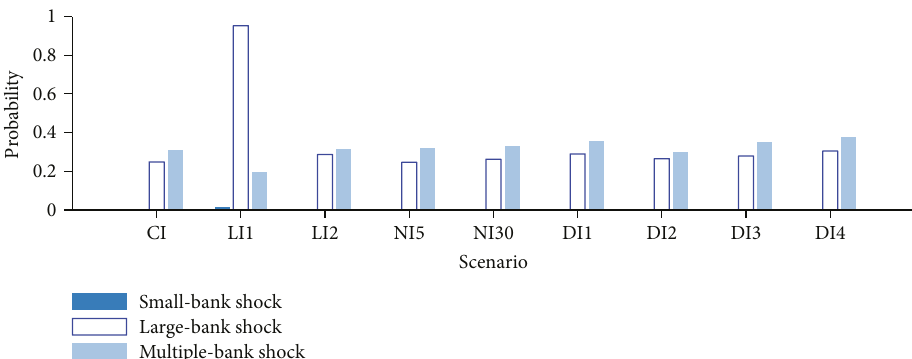
Figure 15: Probability of systemic failure across all scenarios. CI =Complete information; LI =local information; NI =noisy information; DI=delayed information; LI1 and LI2 =scenarios in which banks have access only to information at distance 1 and 2, respectively; NI5 and NI30=scenarios in which noise parameter v is 5% and 30%, respectively; the delay scenarios are de fi ned in Table 1.